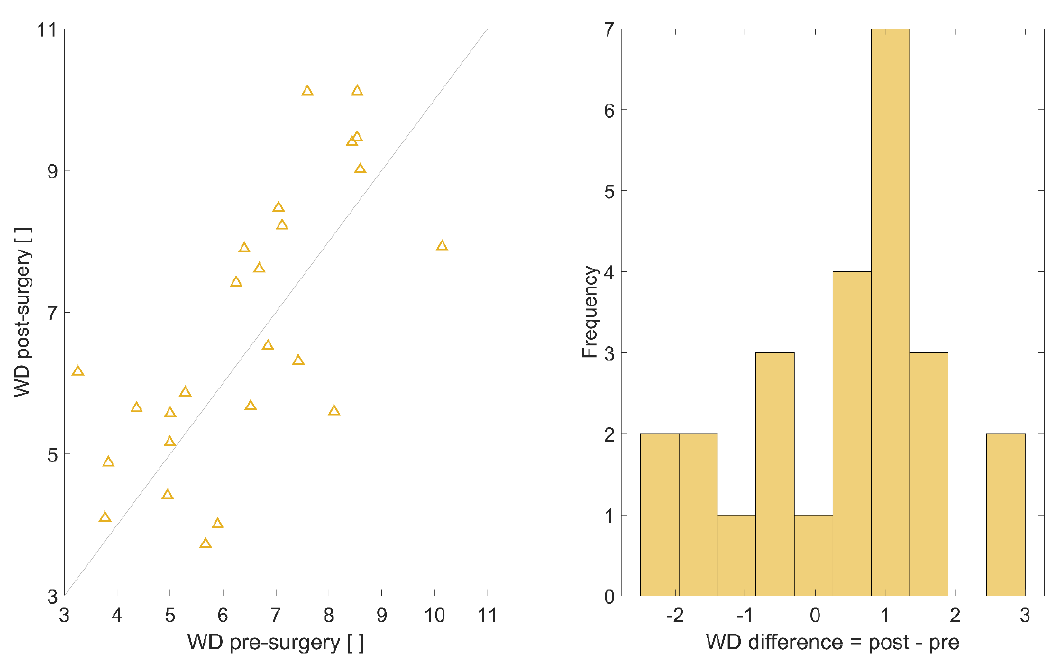
Figure A3. A scatterplot showing weight distribution (WD) index data before and after (6 weeks) HTO surgery. The solid line is the one-to-one line. If there was no change between the two tests, the data point would fall on the one-to-one line. Points above this line indicate higher scores following the surgical intervention. △ , HTO individual data.